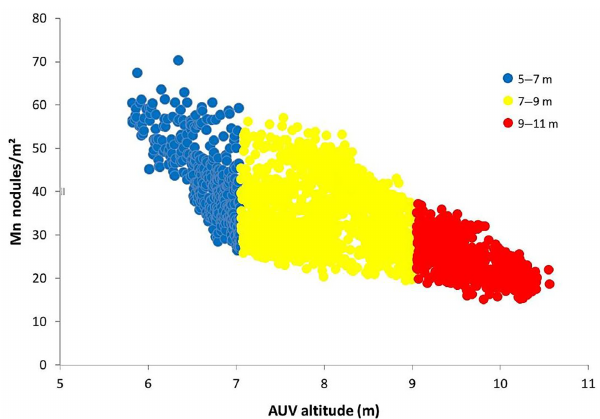
Figure 7. Scatterplot of the AUV altitude (m) and the estimated number of Mn nodules m − 2 inside subarea b. The colors correspond to the color scale in Fig.